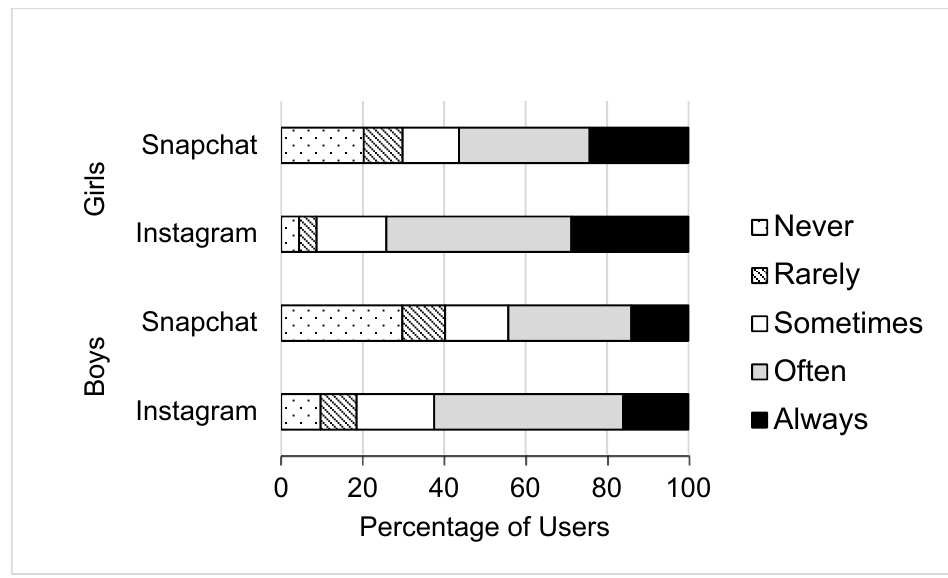
Figure 1. Frequency of social media site use among adolescent girls and boys.